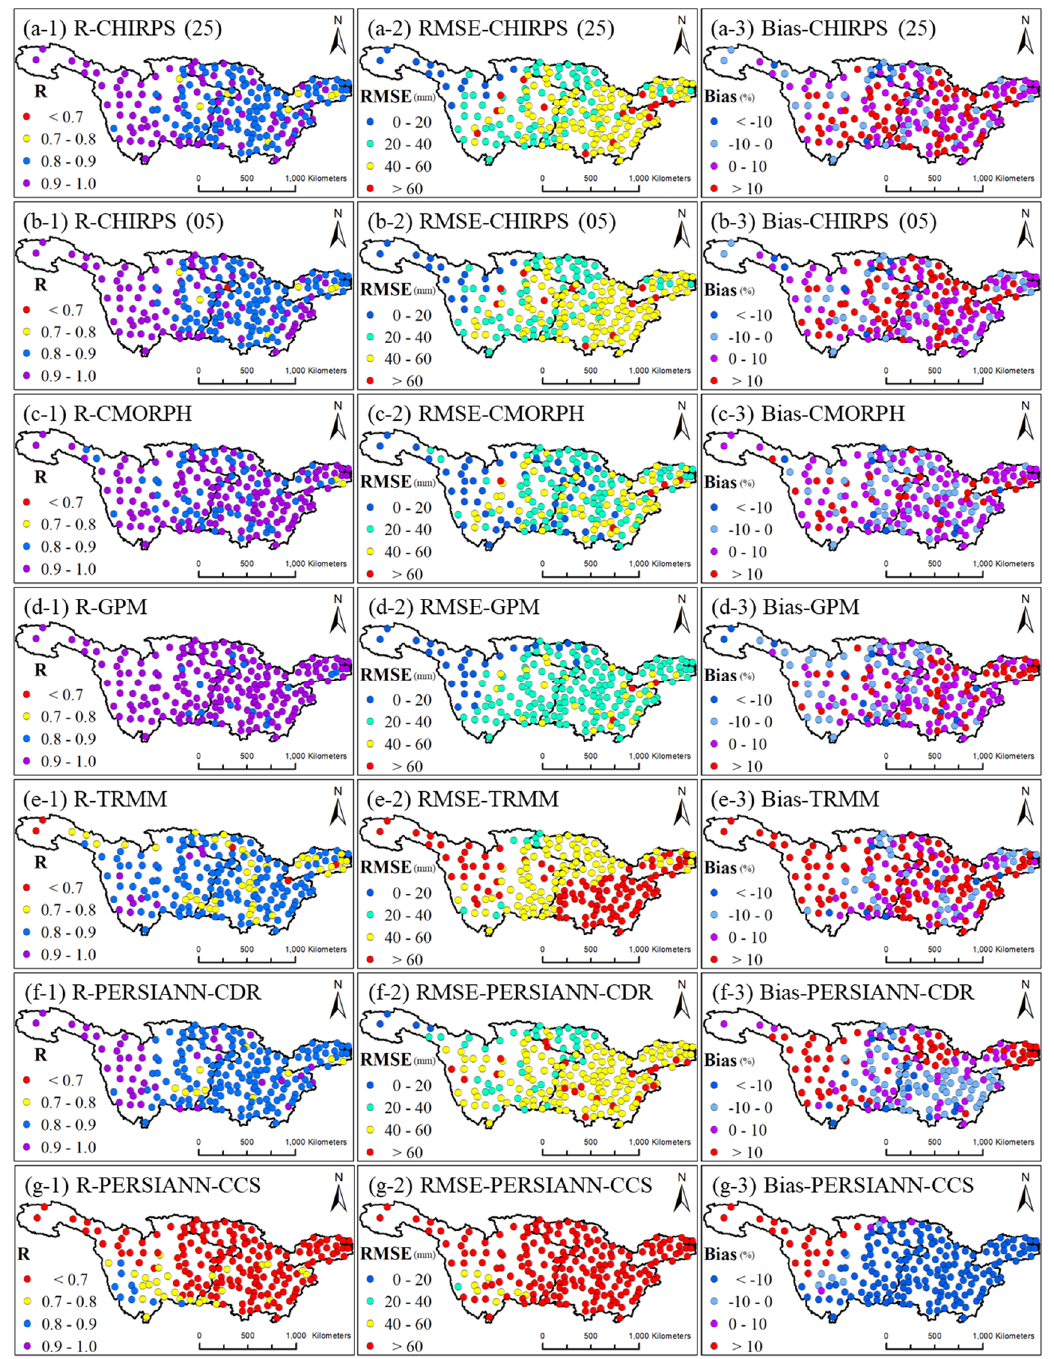
Figure A1. The spatial distribution of the R , RMSE , and Bias of SPPs on the monthly scale.